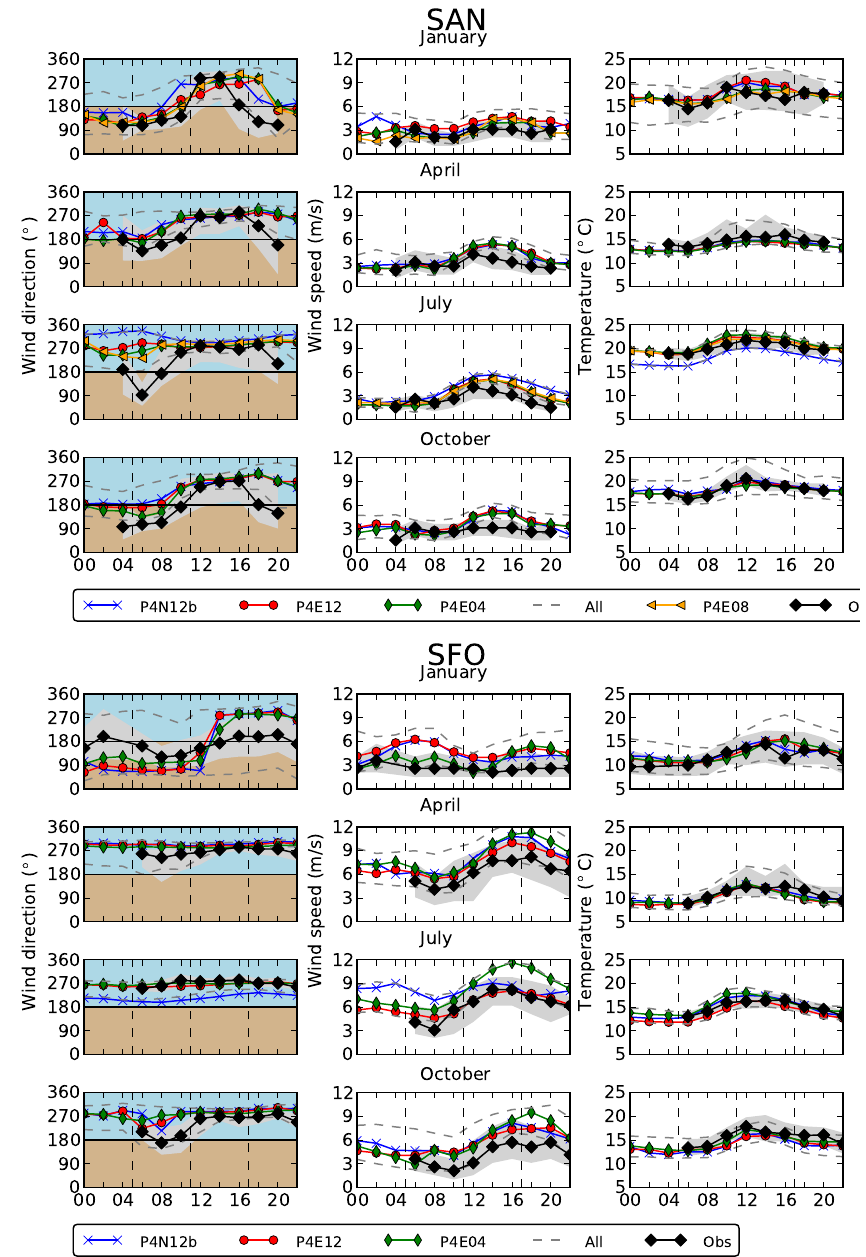
Fig. 6. Diurnal cycle of the surface wind direction, wind speed and temperature at SAN and SFO for January, April, July and October 2009 (local time) in simulations varying the boundary conditions and nesting options using median. For the wind direction, the blue area represents wind from the west while the tan area is for winds from the east. The grey envelope represents the upper and lower quartiles of the observations. The grey dotted line shows the upper and lower quartiles for all the simulations together. 30